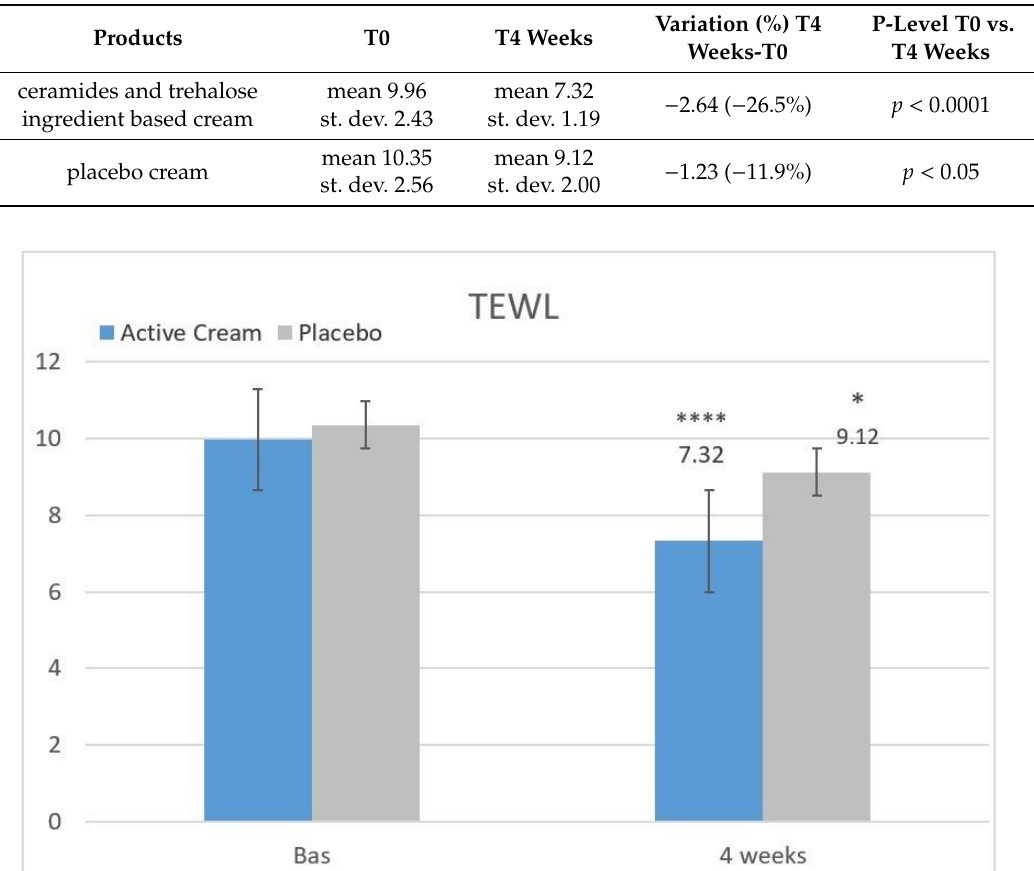
Table 3. Mean values, standard deviations, variations, and statistical significance ( t -test) of transepidermal water loss on 20 analyzed subjects.